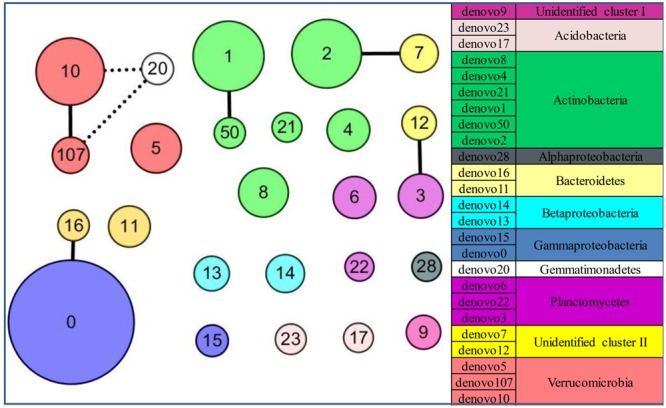
The patterns of keystone taxa for the community structure in the glacial foreland. Network of co-occurrence of abundant OTUs based on Spearman correlation analysis. The size of each node is proportional to the average abundance at the five sites. A connection stands for a strong (coefficient > 0.75 marked with a solid line or coefficient < –0.75 marked with a dashed line) and significant (p-value < 0.05) correlation.